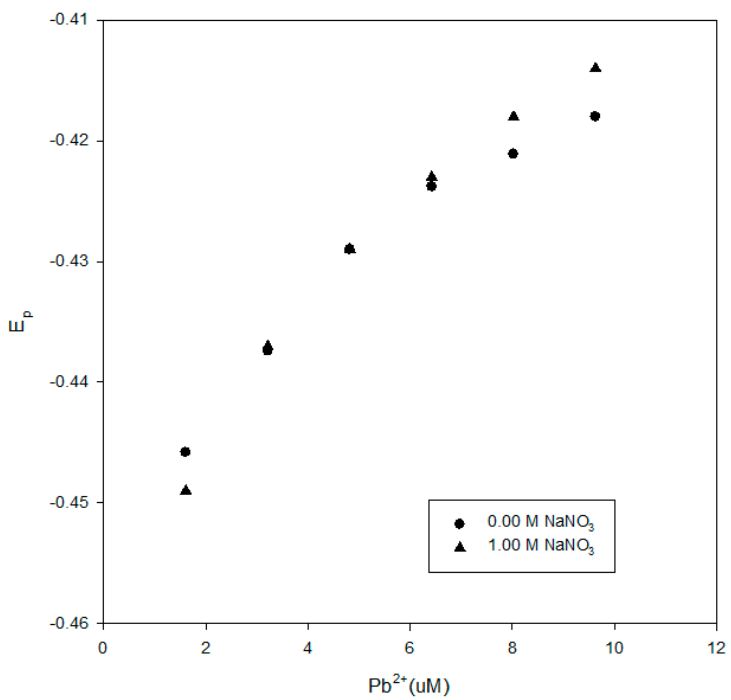
Figure 10. Comparison of DPP results for Pb 2+ at pH 8 in the presence of 100-mg/L Suwannee River NOM with and without 1.00-M NaNO 3 .